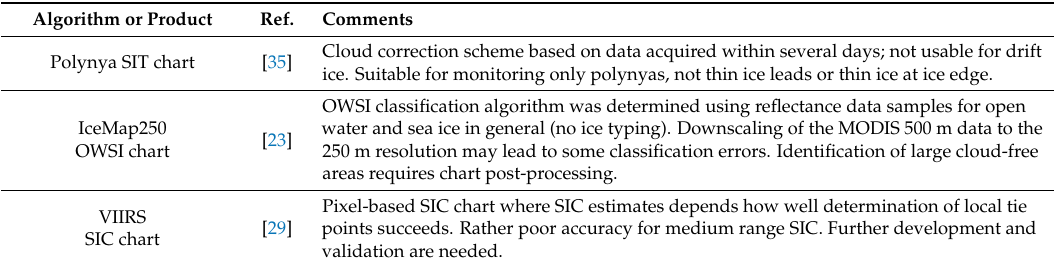
Table 1. Shortcomings of new Moderate Resolution Imaging Spectroradiometer (MODIS) and Visible Infrared Imaging Radiometer Suite (VIIRS) sea ice products when using them for the development and validation of sea ice products from microwave sensor